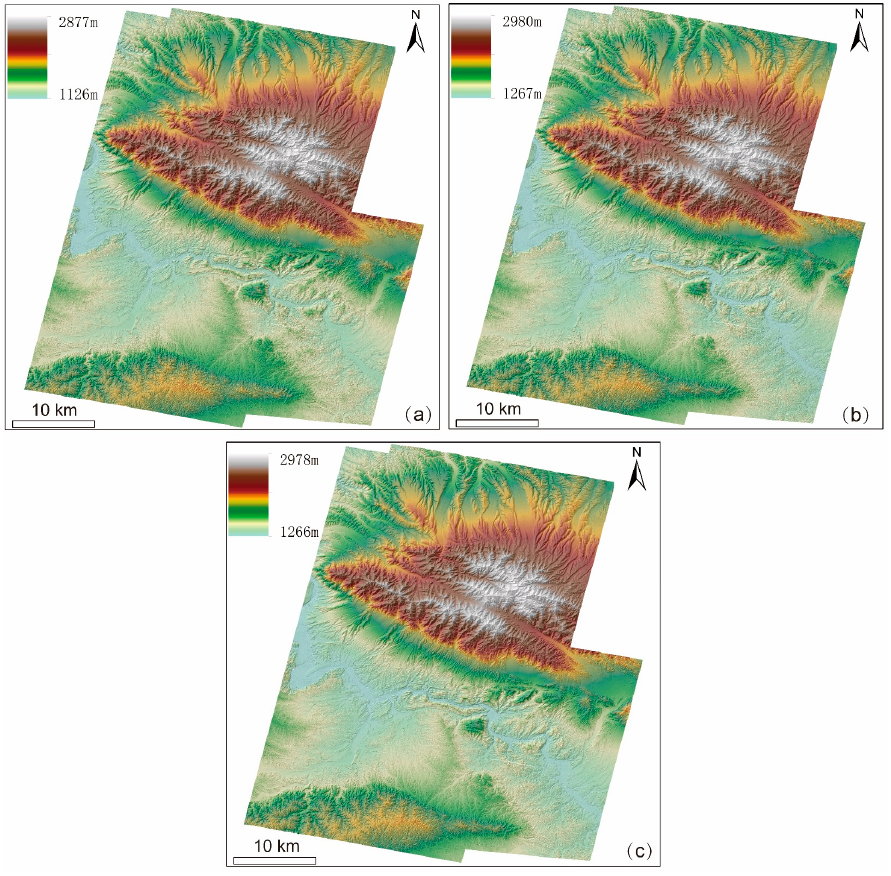
Figure 7. ( a ) GF-7 DEM Method1 ; ( b ) GF-7 DEM Method2 ; ( c ) GF-7 DEM Method3 . Table 4. Accuracies of the GF-7 DEMs based on Table 4. Accuracies of the GF-7 DEMs based on checkpoints.